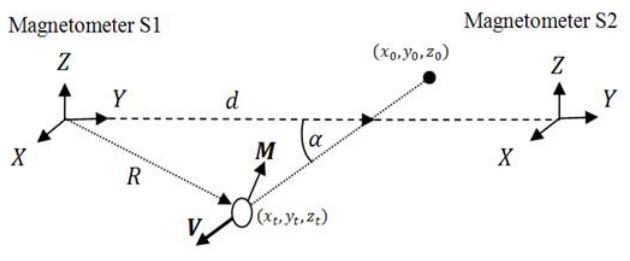
Figure 1. The experimental setup comprises two vector magnetometers that measure the change in magnetic flux generated by the motion of a ferromagnetic object (see solid line) along a straight line at a constant